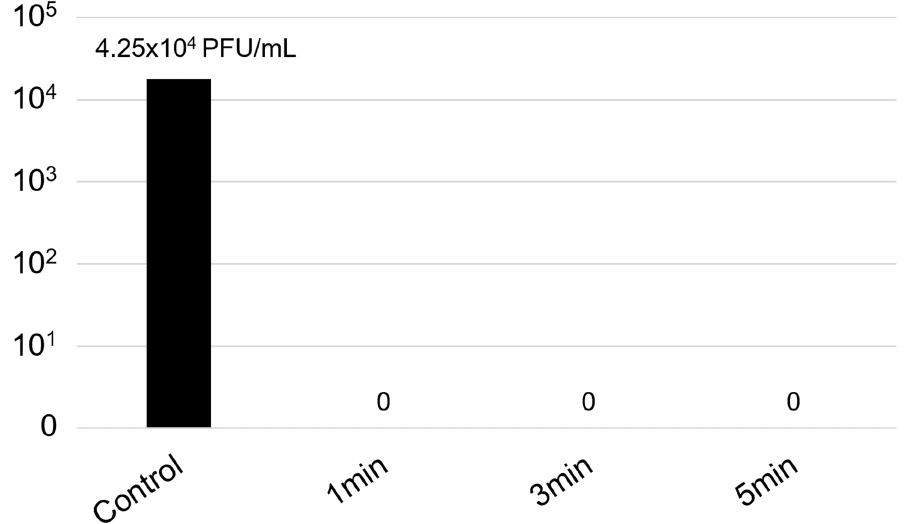
Figure 4. Viral titer (in PFU/mL) of the Chikungunya virus on face mask samples exposed to the UV-C